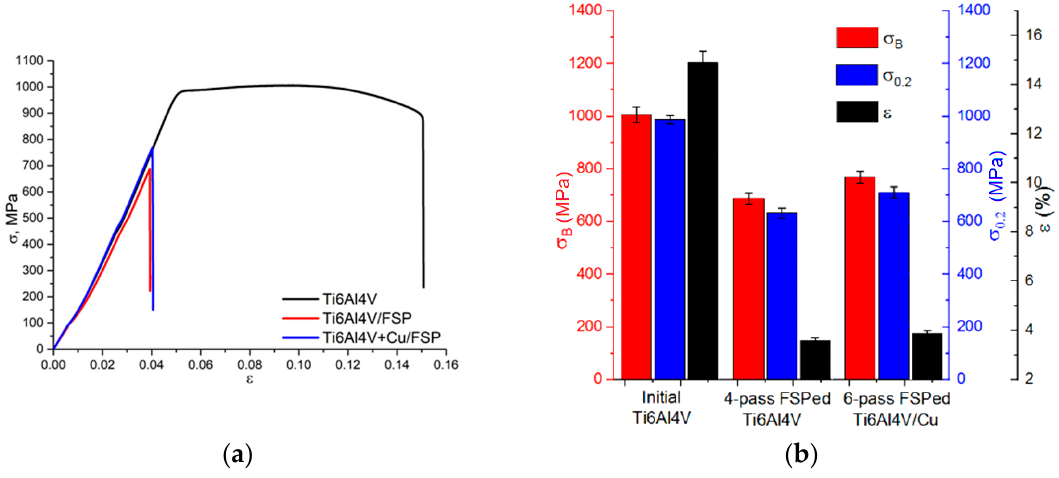
Figure 14. Tensile stress–strain curves ( a ) and mechanical characteristics of the samples ( b ). SEM SE fractography images of both FSPed Ti6Al4V and Ti6Al4V/Cu allowed for